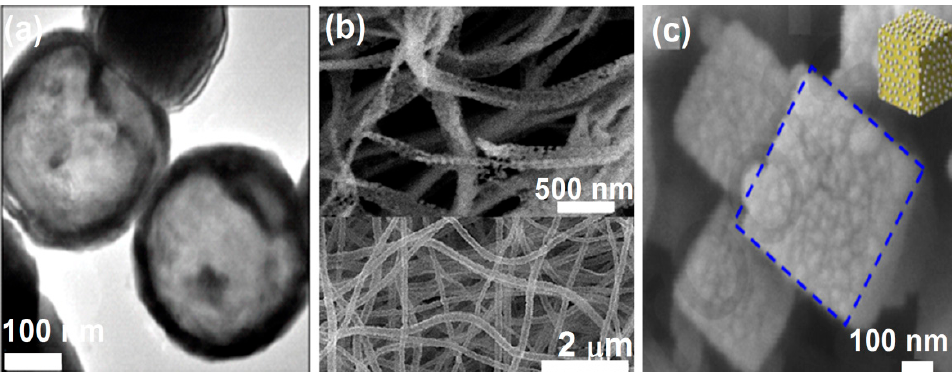
Figure 9. ( a ) High-resolution TEM of Zn 0 . 3 Fe 2 . 7 O 4 nanospheres (Reproduced with permission from [52]. Copyright American Physical Society, 2019). ( b ) SEM images of nanotubes in the lower panel and SEM images of nanobelt in the upper panel (Reproduced with permission from [58]. Copyright Elsevier, 2018). ( c ) SEM images of hollow porous core-shell ZnFe 2 O 4 /AgCl nanocube (blue dotted line represents cubic facet) coated with EDTA-Ag nanoparticles (Reproduced with permission from [59]. Copyright Elsevier, 2020).